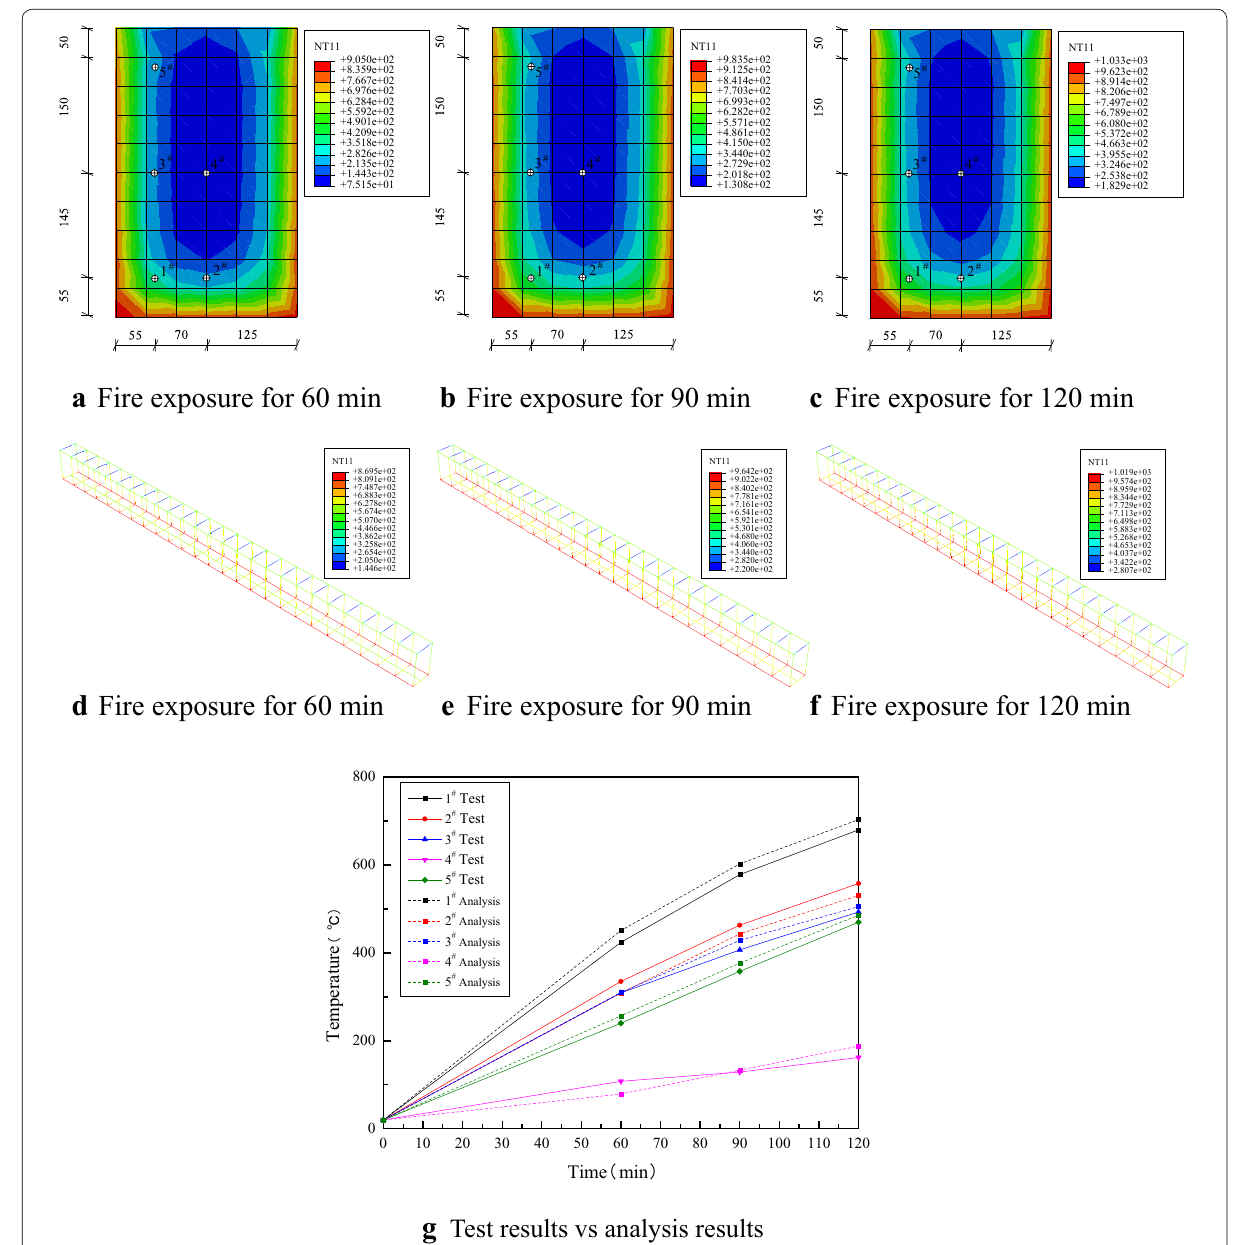
Fig. 2 Temperatures simulation of sectional